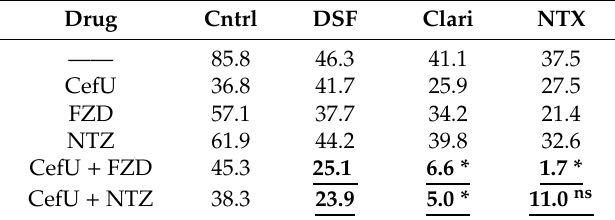
Table 3. Drug-exposure experiment for combinations with DSF, Clari, and NTX of a 7-day-old stationary phase culture after a 7-day treatment. B. burgdorferi viability (in %) in a 7-day-old stationary-phase culture after the drug exposure experiment at a Cmax concentration for each drug. Results underlined are the direct comparison replacing DSF with Clari or NTX. Drug Cntrl DSF Clari NTX —— 85.8